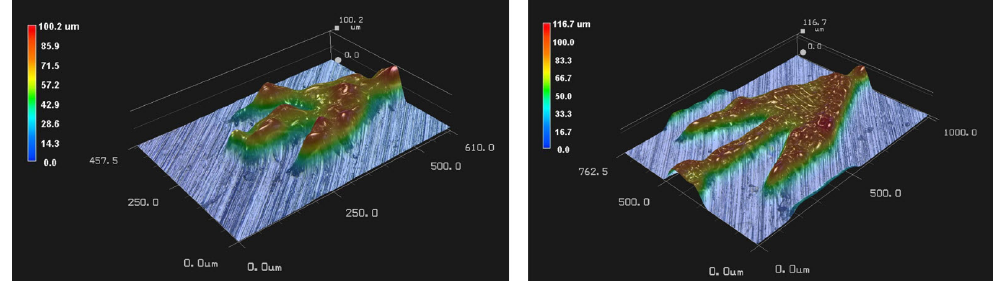
Figure 3. The pictures represent the basic element of structure manufactured by SLM. ( left ) Structure A and ( right ) structure C of the experimental set-up (Figure 2) corresponding to the smallest and largest lengths specified in Figure 4. Colours indicate height measured from the steel platform. This process results in a series of parallel capillaries. Each capillary is a periodic repetition in the longitudinal x direction of an elementary pattern shown Figure 4 left panel. The blue region in the rectangle is the melted metal of a height 100 µ m while the white region is an empty cavity bounded by the walls of the blue region. The cavity constitutes the elementary cell of the capillary. Note, that the parallel capillaries are separated by the walls of a width at least larger than W 3. Thus, water can only flood from one capillary to the other by passing over the wall. The geometric characteristics of the fin shape is given in the table of Figure 4 right panel. In the elementary cell, we distinguish the straight channel, called channel , from the wider region constituted by the fins, called V region. Figure 2 right panel shows the top view of the CAD drawing of the three sets of capillaries called structures A, B and C. Their respective widths are 5, 5 and 6 mm. Diameter and height of the platform are 50 and 10 mm respectively. Left panel of Figure 2 is a photo of the round platform and three adjacent structures manufactured by SLM at the center.